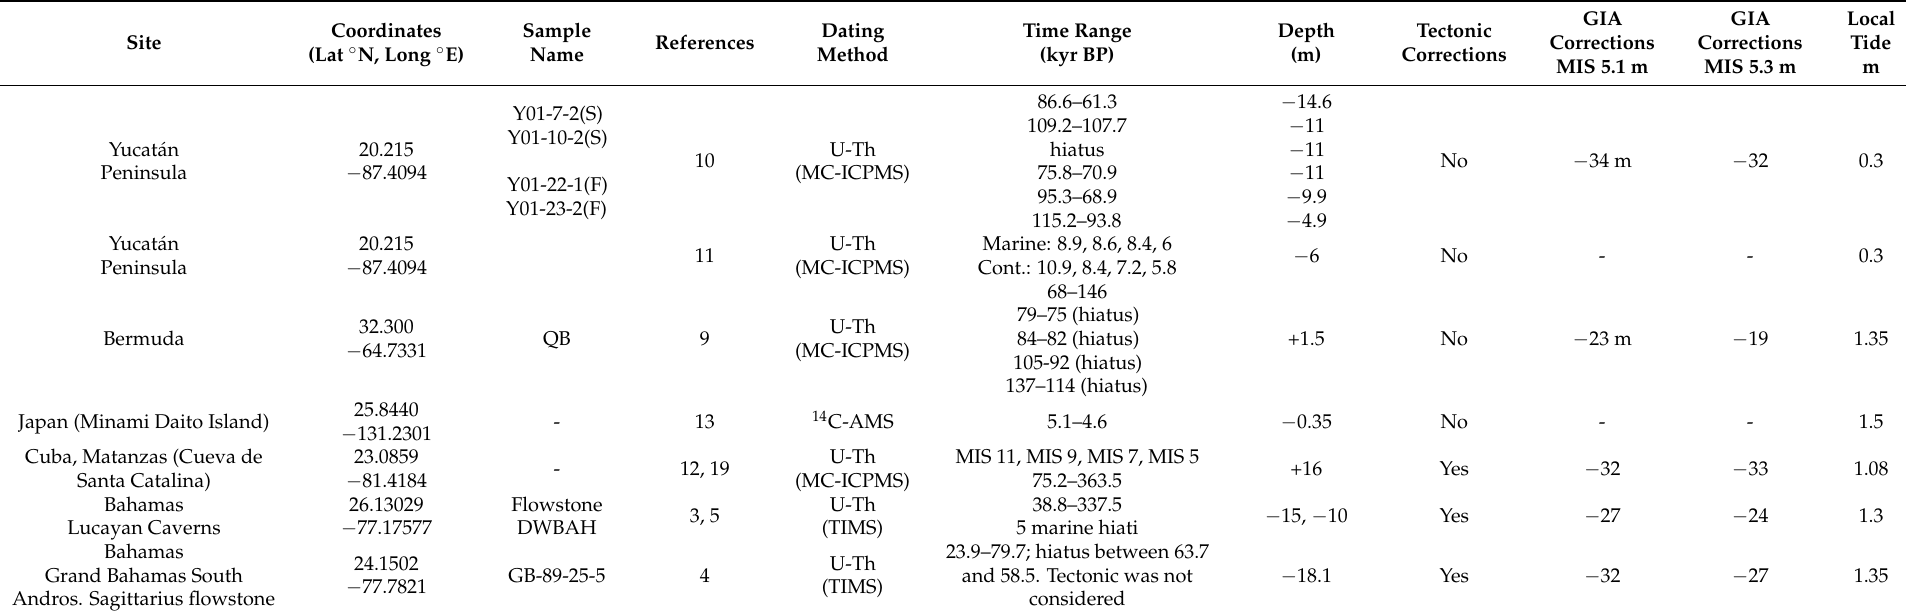
Table 1. Locations and geographic coordinates of the caves and speleothems reported in this study, with information on references, dating method, time range, elevation, GIA, Tectonic corrections and local tide